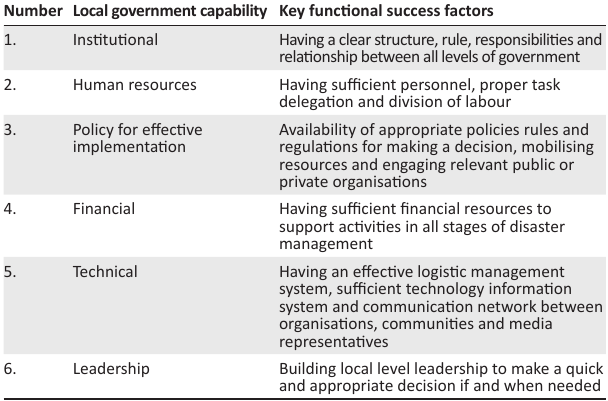
TABLE 1: Local capability requirements and critical factors of disaster